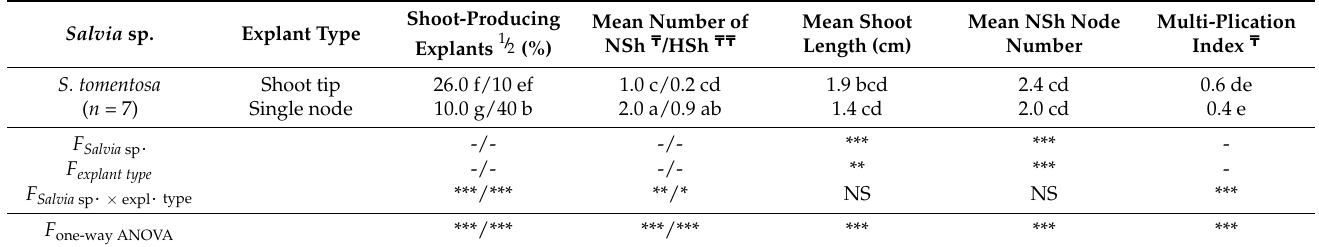
Table 1. Effect of Salvia species and explant type on axillary shoot production of explants excised from in vitro seedlings of Greek sage species, at the establishment stage of in vitro cultures on a hormone-free MS medium.